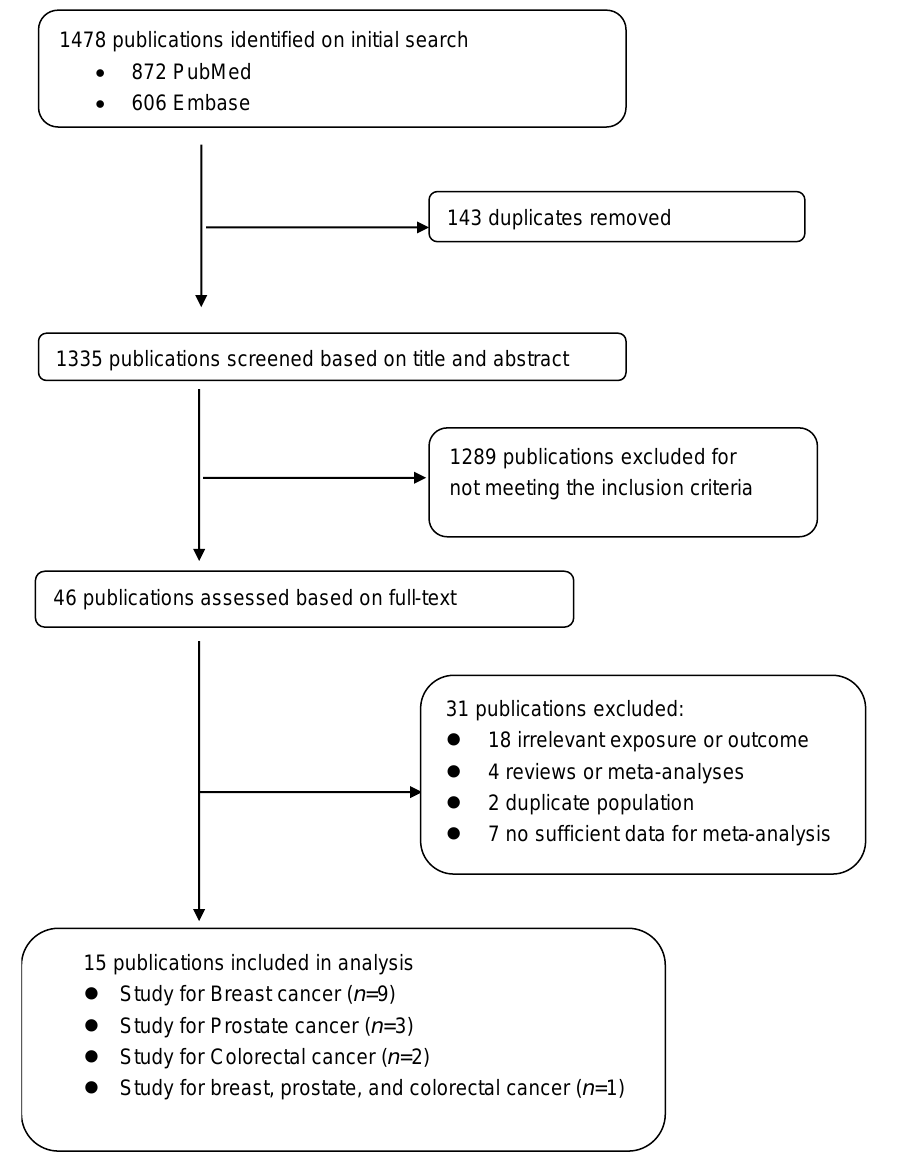
Figure 1. Flowchart for Study Selection.